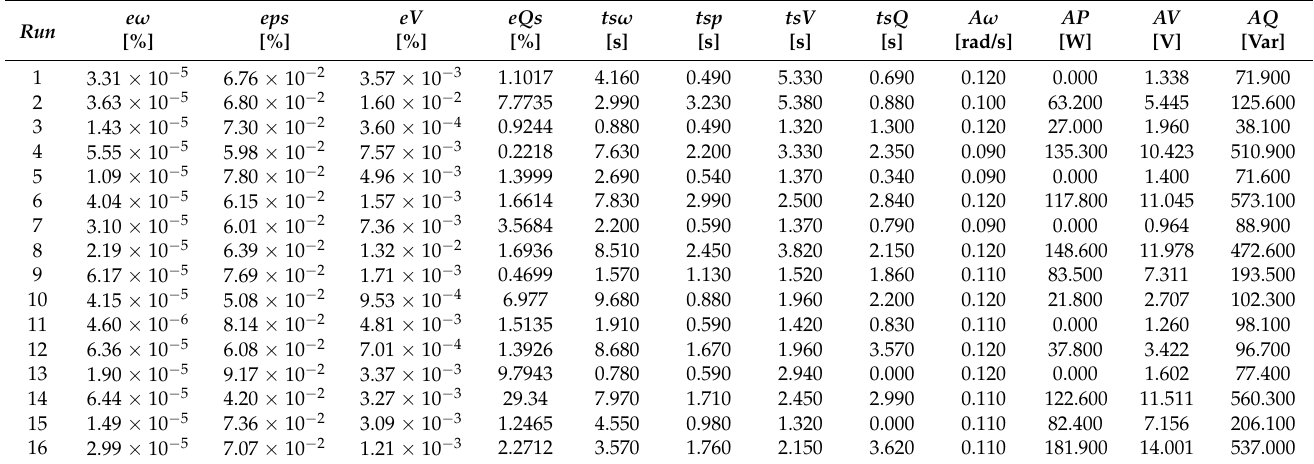
Figure 6. The results of two experiments using different value sets of the secondary control parameters. Note that the merit factors were measured at t = 50 s, clearly showing different overshoots in frequency, voltage, and reactive power. Table 4. Response variables for each previous experimental run *.